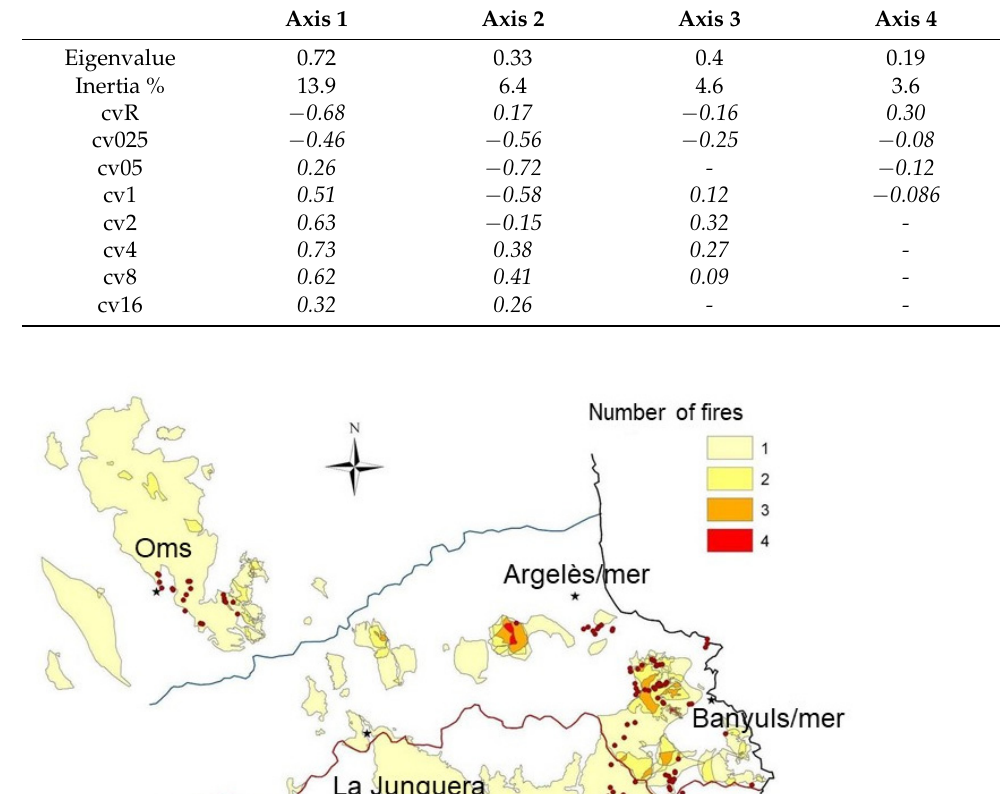
Figure A3. Number of samples ( y -axis) as a function of the number of years since a fire ( x -axis). Figure A4. Mean cover values of the rock and three vegetation layers in seven classes (A to G) cor- responding to a vegetation gradient ( x -axis) and the first eight years after a fire ( y -axis) (see Figure 1). Dashed line: the prefire gradient. The dimension of a square is normalized by the maximum cover of the layer considered.